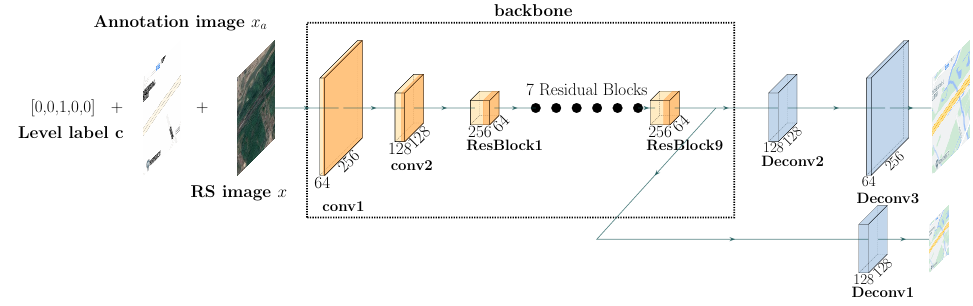
Figure 5. The architecture of the multi-scale